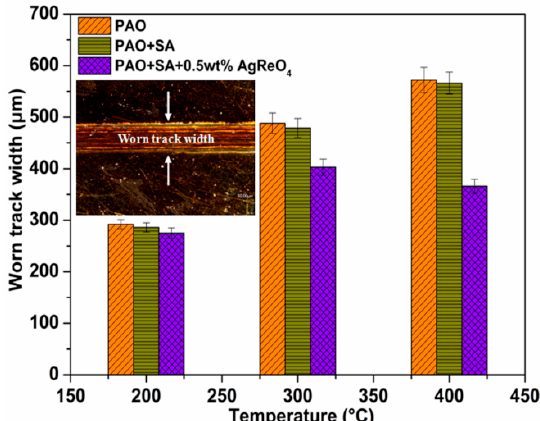
Figure 10. The mean width values of worn tracks lubricated by different lubricants at various temperatures.